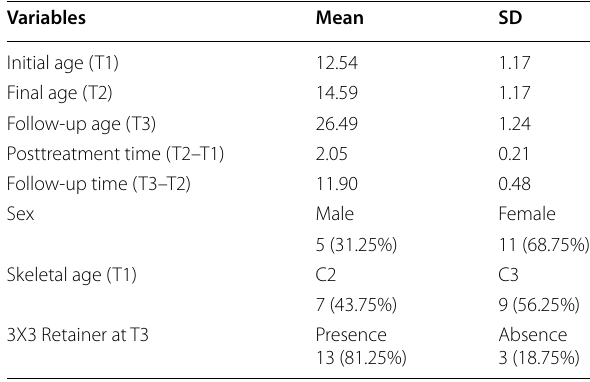
T1—Pretreatment; T2—Posttreatment; T3—Follow-up C2 and C3—cervical vertebral maturation